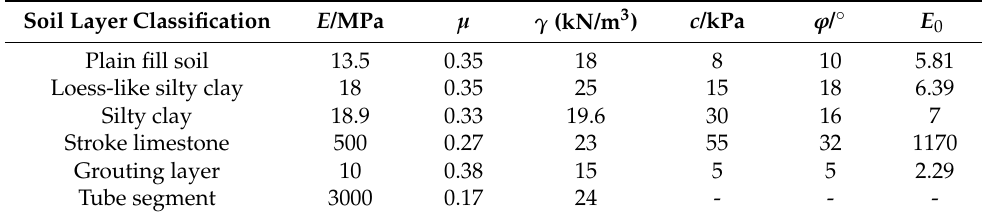
Table 1. Soil layer materials and grouting layer parameters.